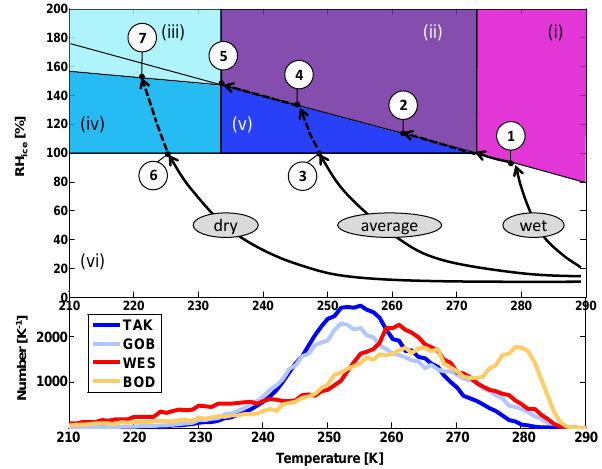
Fig. 4. Schematic of cloud types (Roman numerals: (i) water, (ii) mixed-phase, (iii) cirrus, (iv) COLD HET, (v) WARM HET, (vi) clear sky) and cloud formation processes (Arabic numerals: (1) WATER, (2) MPC’, (3) WARM HET, (4) MPC, (5) CIRRUS’, (6) COLD HET, (7) CIRRUS) possible along the air parcel trajecto- ries, depending on a schematically indicated initial moisture content (“wet”, “average”, “dry”). Straight line containing (1) and (5) ap- proximates RH w = 100% (for simplicity extrapolated to T > 273K). Straight line separating colored regions (iii) and (iv) follows the pa- rameterization of Koop et al. (2000) for 200nm solution droplets. Bottom panel shows the distribution of water saturation tempera- tures of individual trajectories, given their actual initial moisture content. See text for